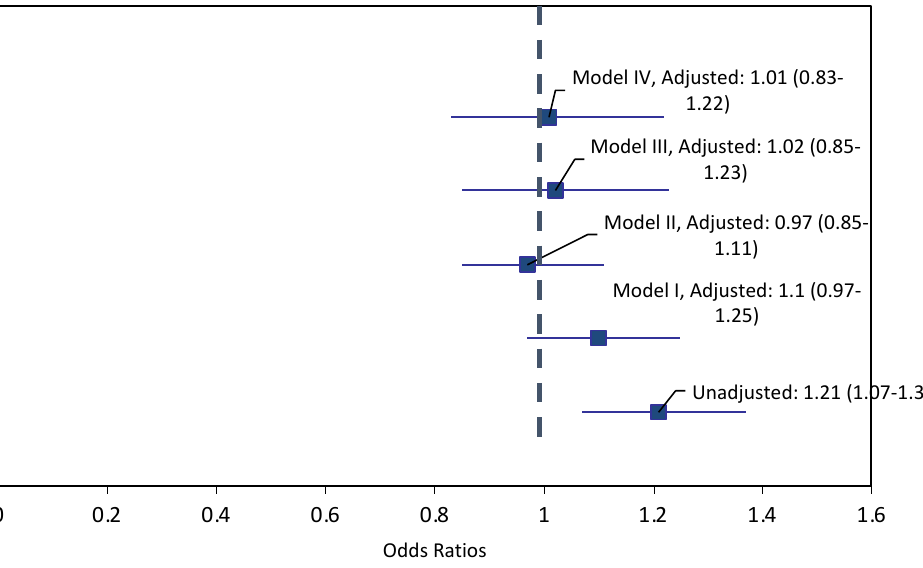
Figure 2. Association between cannabis use and detectable HIV viral load: Results from logistic regression analyses.